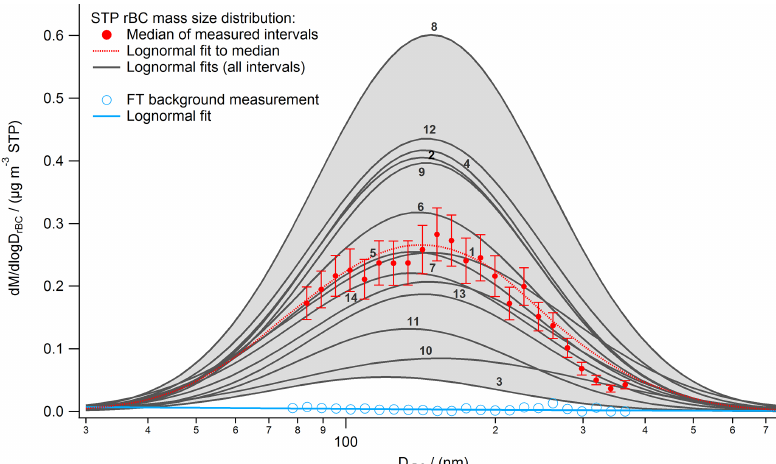
Figure 5. Median rBC mass size distribution (red dots) out of the 14 measurement sequences (see Fig. 2) in the Pagami Creek fire plume. Log-normal fits (solid lines) are shown for all sequences for the measured size range of 80–250nm. The grey shaded area represents the range between maximum and minimum log-normal fit. The mean total rBC mass concentration (accounting for the data outside the SP2 range) is 0.03–0.35µgm − 3 (STP) for the 14 sequences in the forest-fire layer, indicated by the numbering. Error bars represent 15% uncertainty (see Sect. 2.2). For comparison the rBC mass of a free tropospheric (FT) background sequence (blue) is shown.